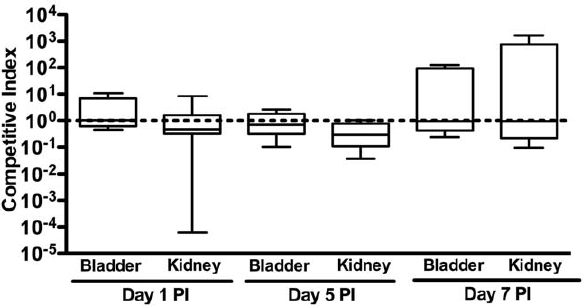
Figure 2. GBS adhere to epithelial cells in a b H/C-independent fashion. Following exposure of 5637 cells to WT or D cylE GBS for 1 h, the monolayers were washed and the number of bacterial adherent to the cells was determined by quantitative culture plating. Adherence frequency was determined as the ratio of adherent to inoculum CFU, expressed as a percentage.